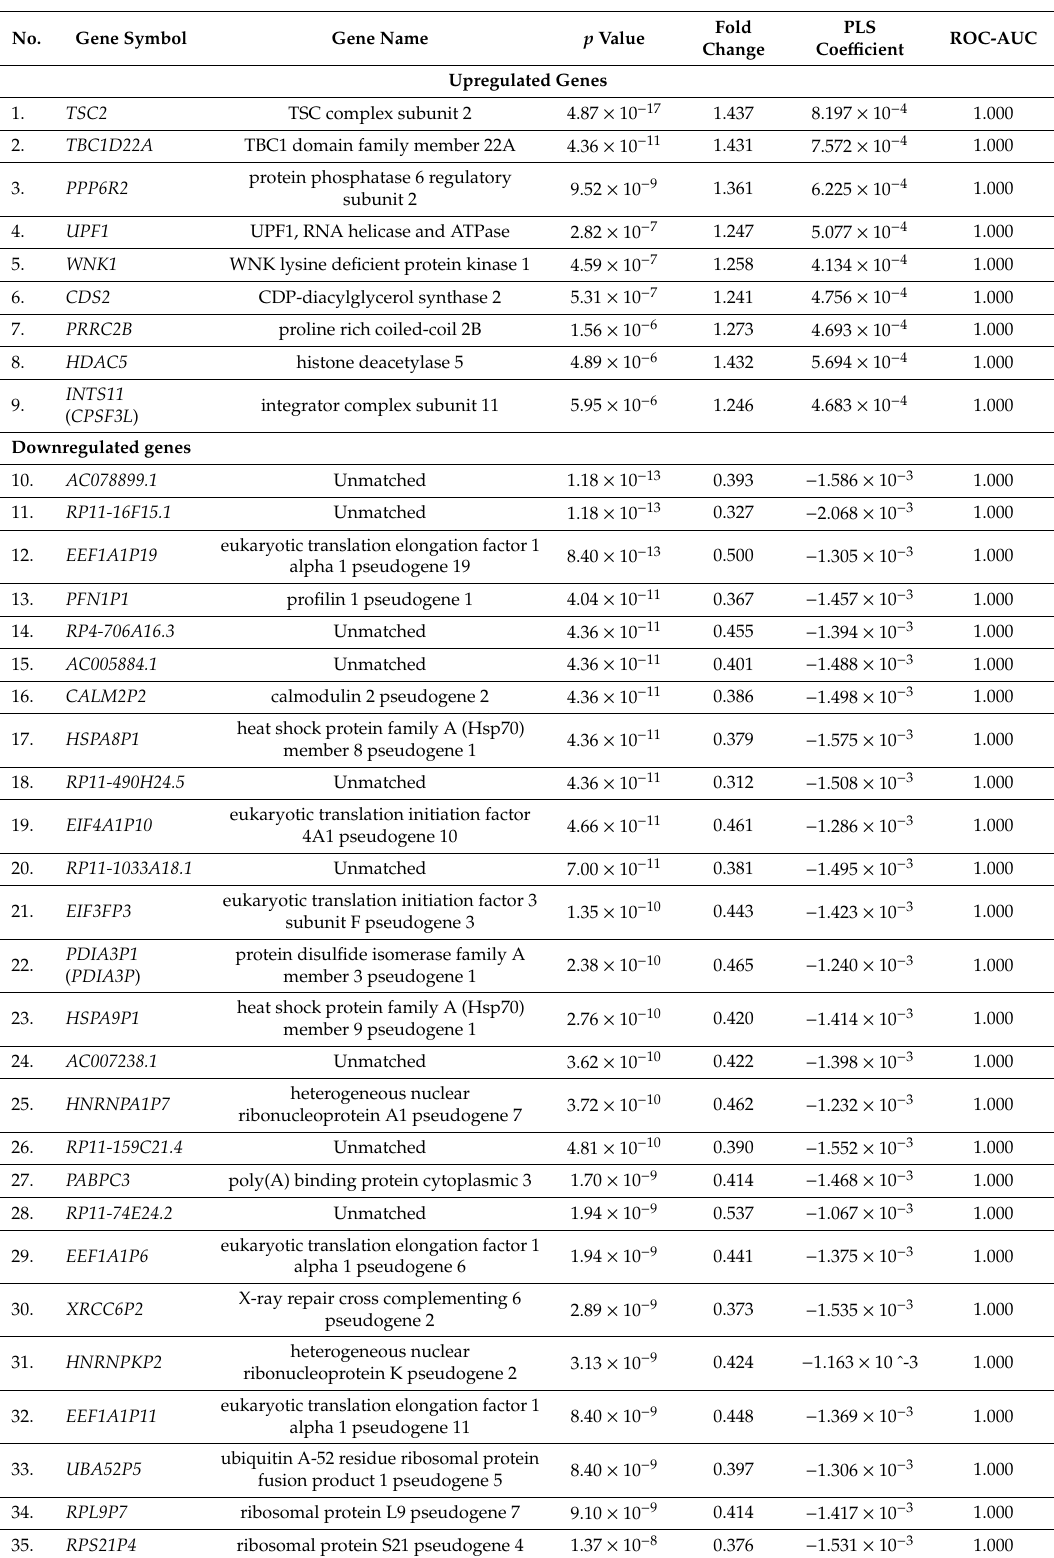
Table 3. The set of 62 di ff erentially expressed genes in seven patients with chronic venous disease vs. seven controls, resulted from DESeq2 analysis ( p < 0.00001) with statistical significance confirmed by Uninformative Variable Elimination by Partial Least Squares (UVE-PLS)